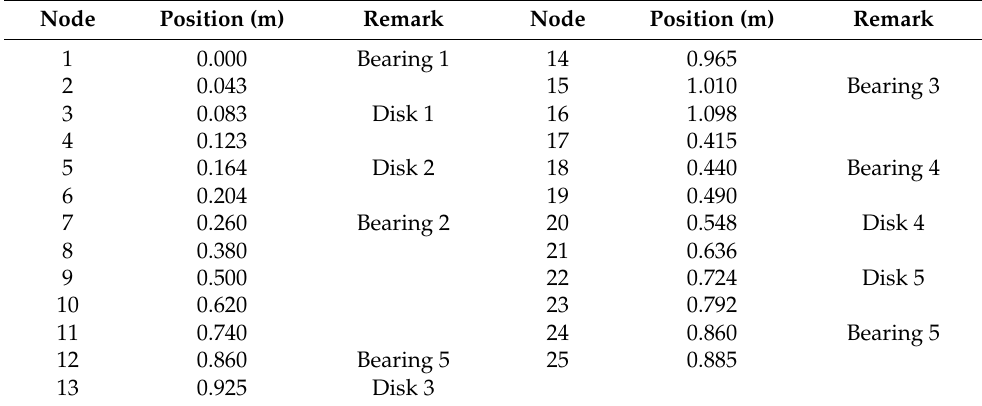
Table 4. Node location.